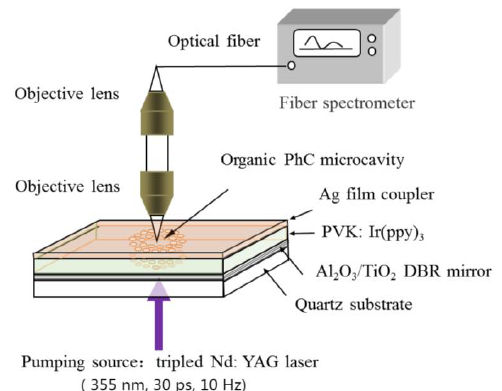
Figure 6. Experimental setup for the detection of an organic QPC microcavity.